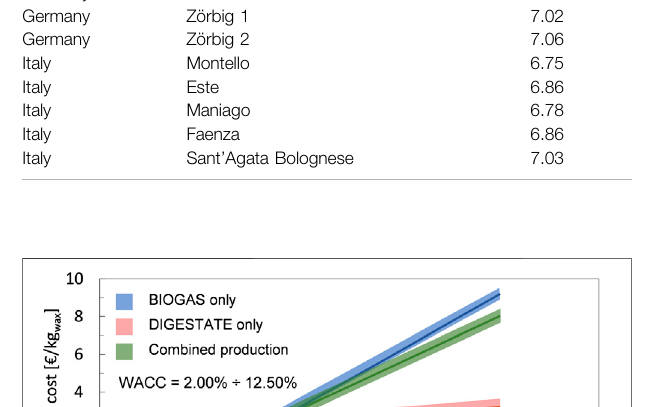
FIGURE 9 | Variation of the cost of wax production in the location of Güstrow depending on the biomethane credits for grid injection after upgrading of biogas.